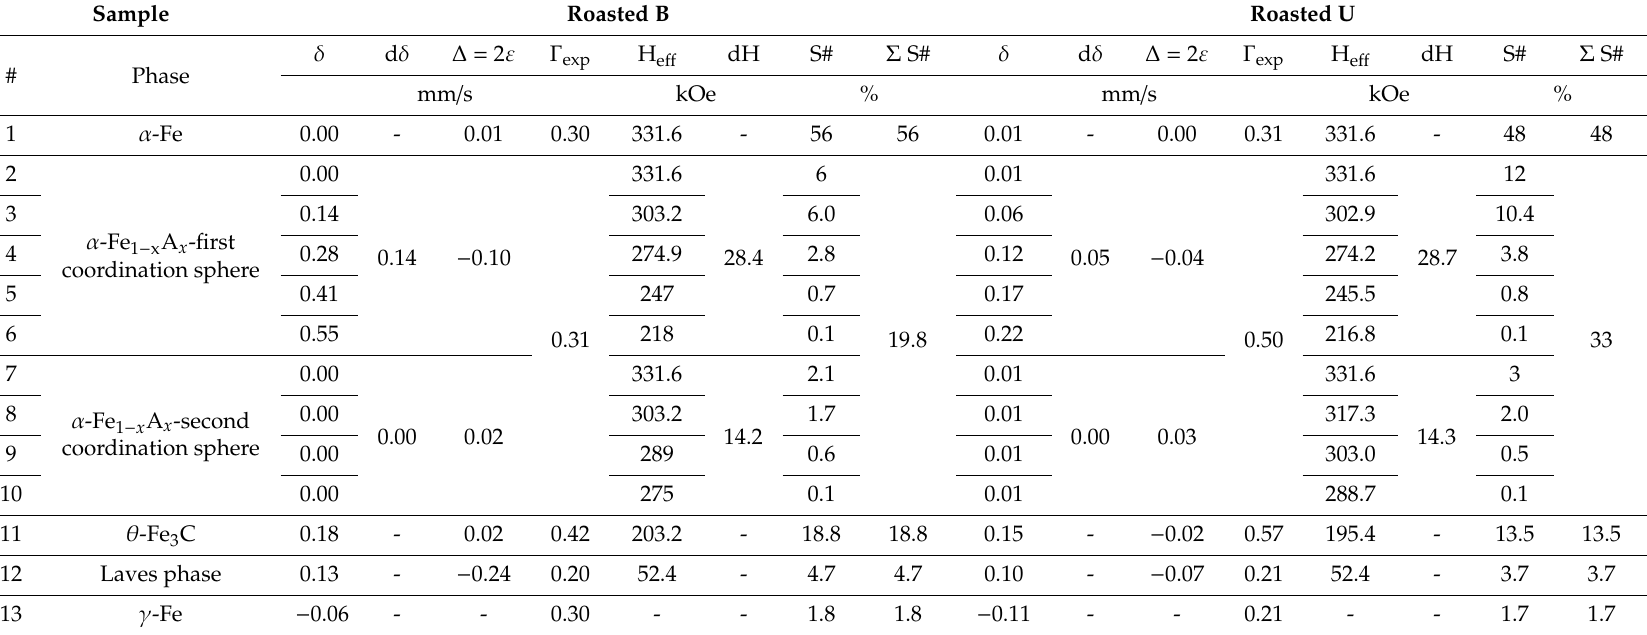
Table 3. Mössbauer spectra parameters and iron phase distribution in the roasted red mud samples B and U at 1150 ◦ C with addition of 13.65% N a2 SO 4 ,